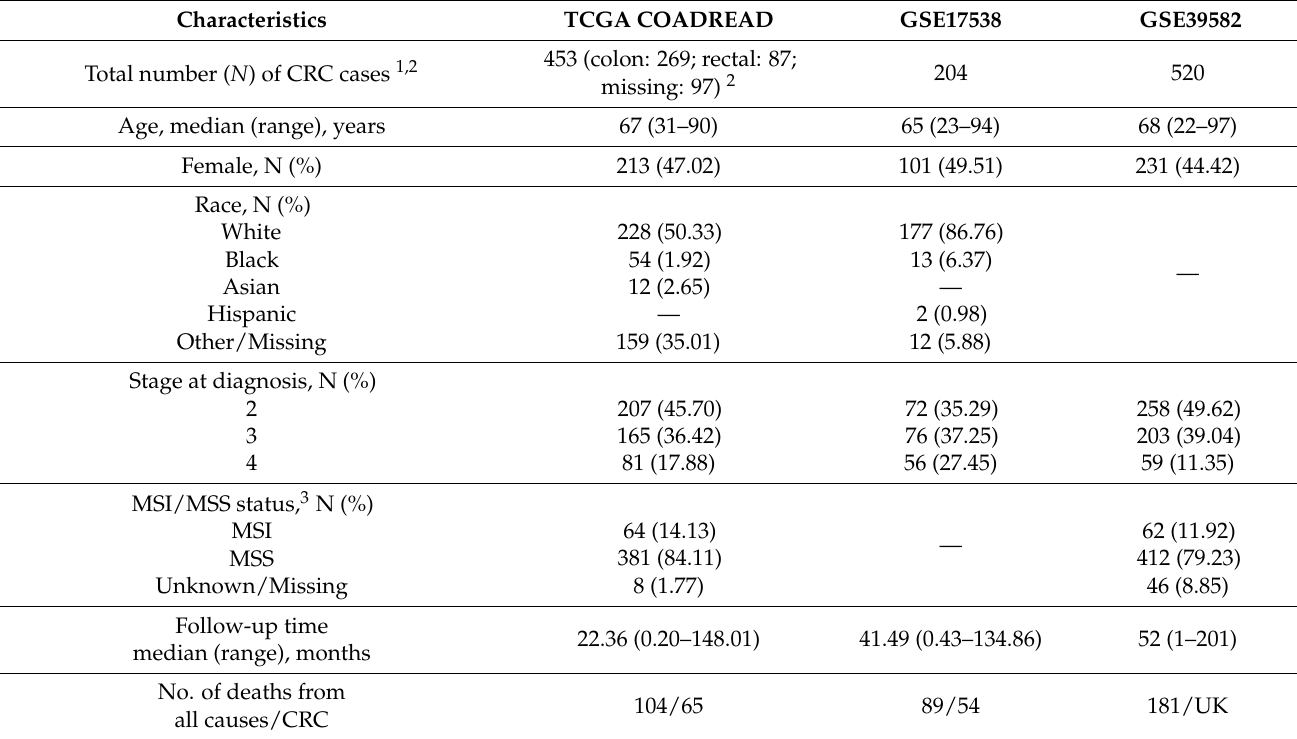
Table 1. Characteristics of individuals with colorectal cancer (CRC) in the TCGA COADREAD, GSE17538, and GSE39582